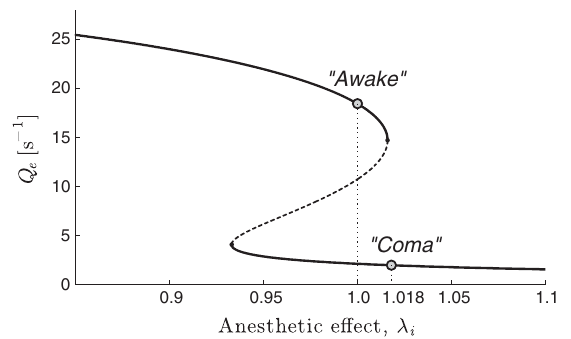
FIG. 3. Vertical slice through the homogeneous equilibrium manifold of Fig. 2 showing the distribution of steady-state firing rates as a function of the anesthetic effect for constant excitation (cid:1) V rest ¼ 1 : 5 mV . We associate the upper, high-firing branch with the awake state, and the lower, low-firing branch with the ‘‘asleep’’ state corresponding to anesthetic-induced coma. Circled points indicate reference states at (cid:13) i ¼ 1 : 0 and 1.018 on awake and coma branches,